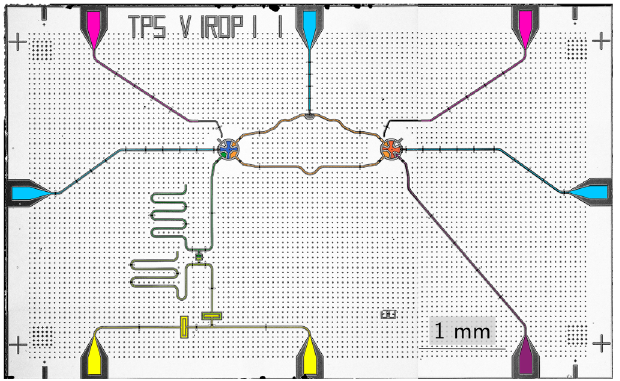
FIG. 5. False color optical micrograph of the sample of the gate qubit (blue). Depicted are the two coupler paths (orange) and the converter mode (dark orange), coupled to the transmission line (purple). Flux lines (cyan) and charge lines (pink) couple to the gate qubit, converter mode, and the coupler. The readout resonator (green) is coupled to a feed line (yellow) via a Purcell filter (light